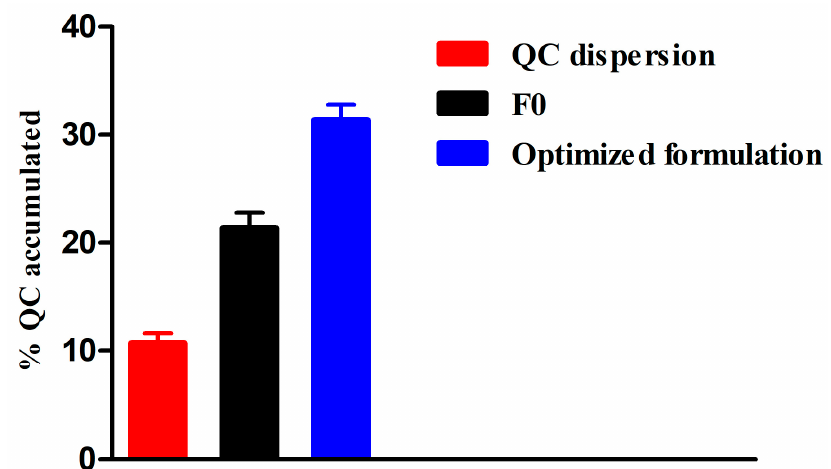
Figure 9. Cumulative amounts of QC deposited in the skin 8 h after application of the optimized formula, F0 and QC dispersion (mean values ± SD, n = 3).